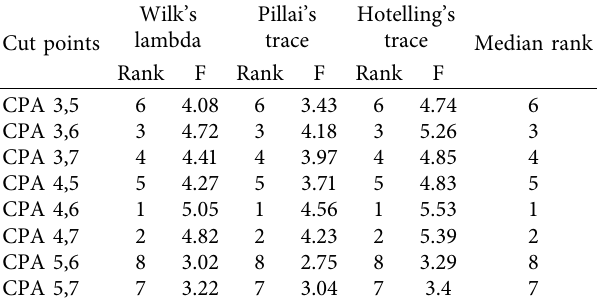
Table 3: Anxiety